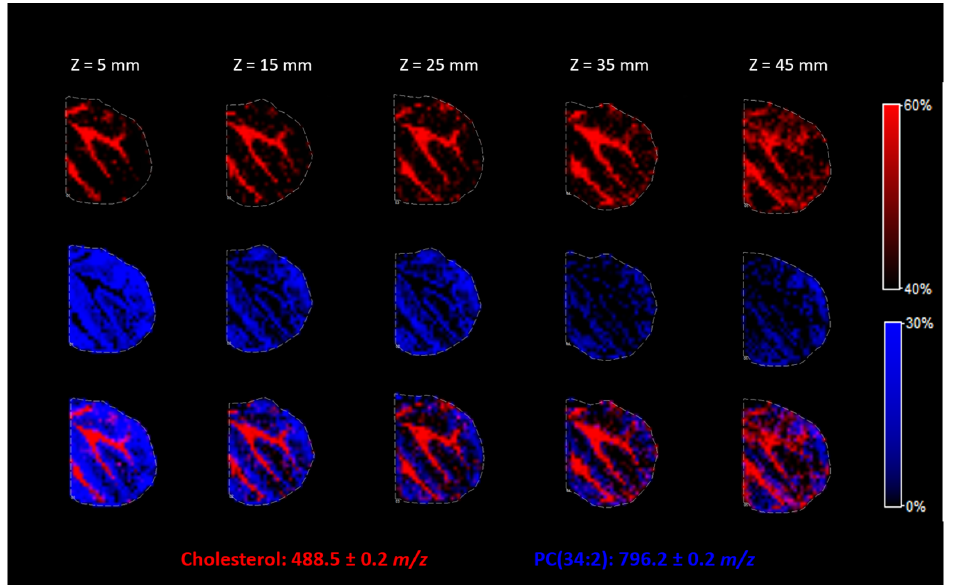
Figure 6. The influence of the nozzle height during matrix deposition on the spatial resolution of obtained